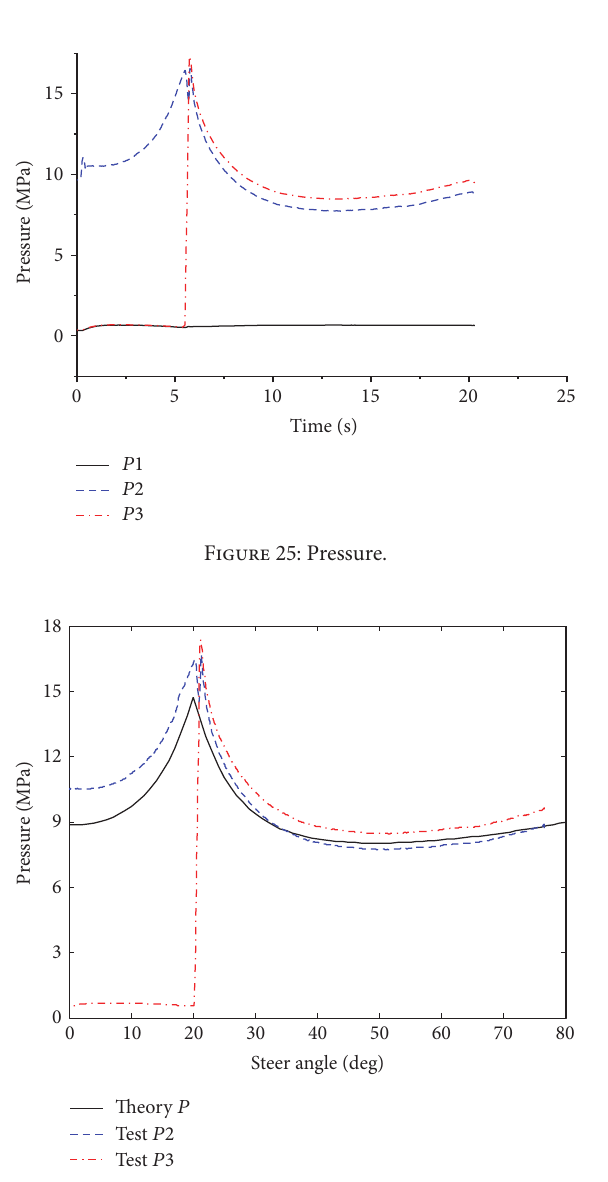
Figure 28: Load torque.